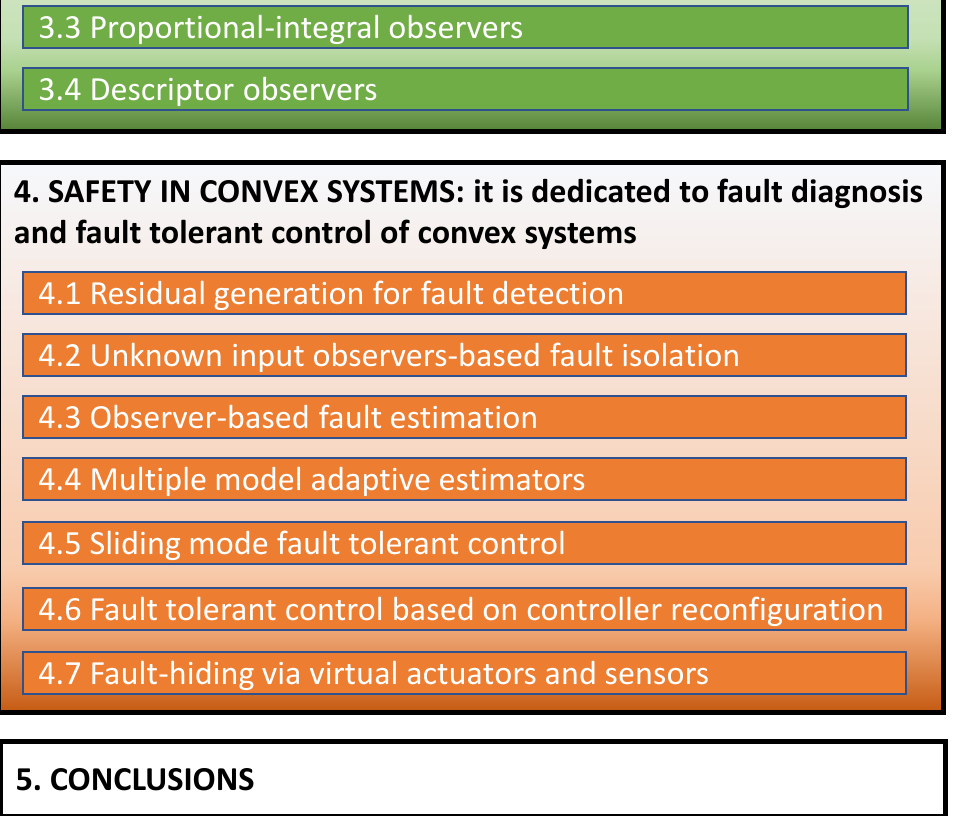
Figure 1. Structure of the